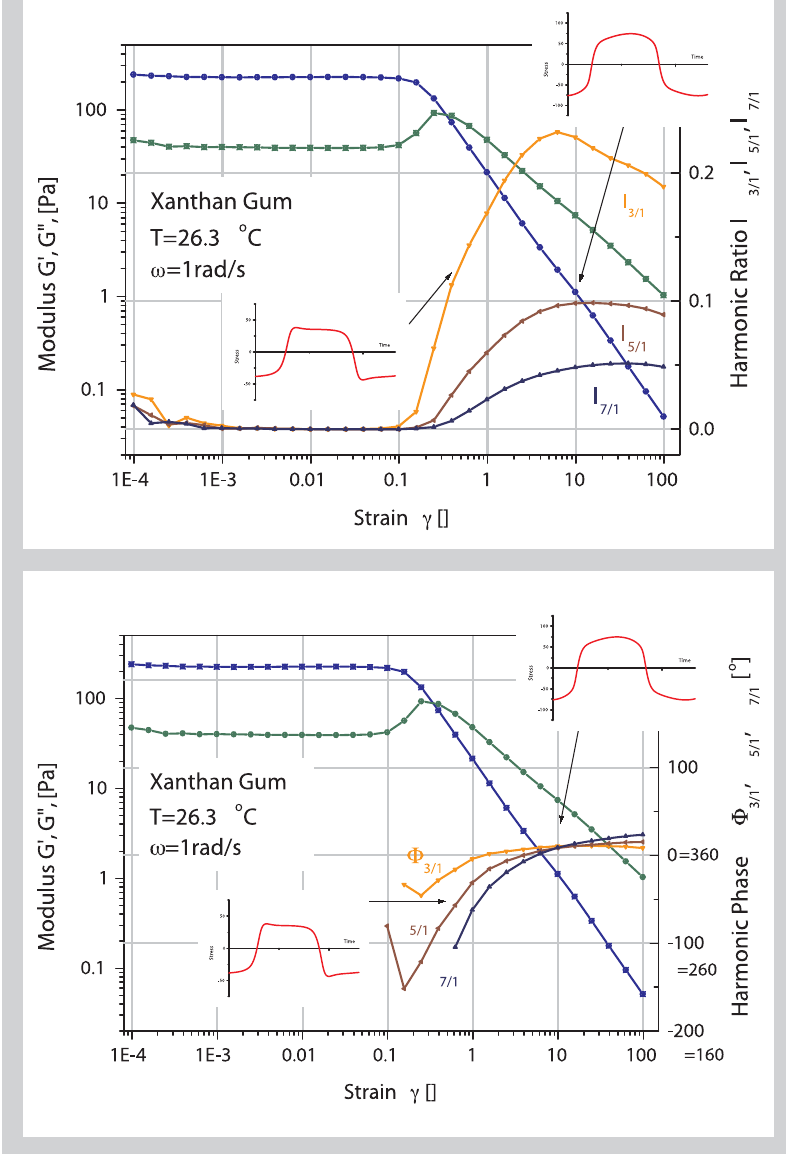
Figure 4 (above): Strain sweep showing G’, G”, 3 rd , 5 th , 7 th harmonic ratio during the transition from the linear to the non- linear regime. Figure 5: Strain sweep for Xanthan gum showing the transition from the linear to the non- linear regime. The harmonic phase increases from nega- tive 90º to 0º at large